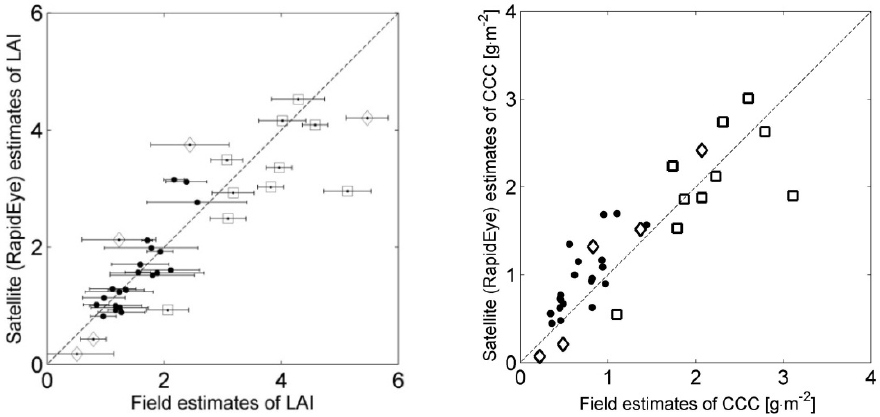
Figure 4. LAI ( left ) and CCC ( right ) estimated from field measurements (X axis) versus RapidEye satellite sensor data (Y axis) estimates. Symbols correspond to: ‘ ● ’ fruit trees, ‘ □ ’ maize and ‘ ◊ ’ other vegetation types. Error bars in LAI indicate standard deviations of the LAI